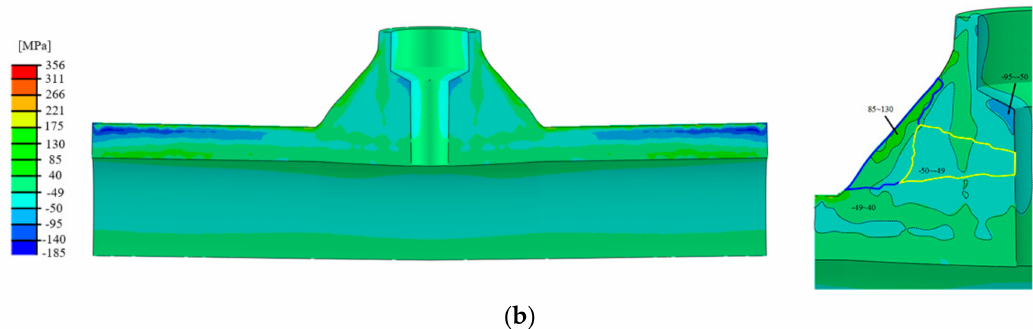
Figure 7. Residual stress distribution: ( a ) stress distribution in the circumferential cut surface; ( b ) stress distribution in the longitudinal cut surface.